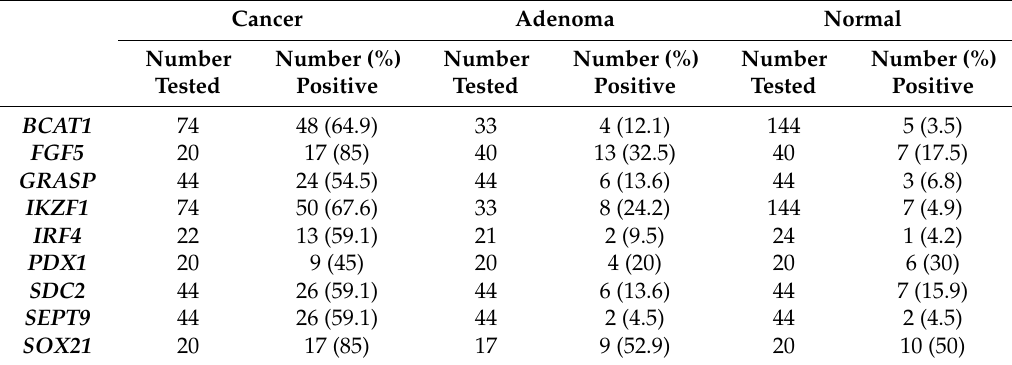
Table 2. Frequencies of detection of methylated DNA using methylation-specific PCR